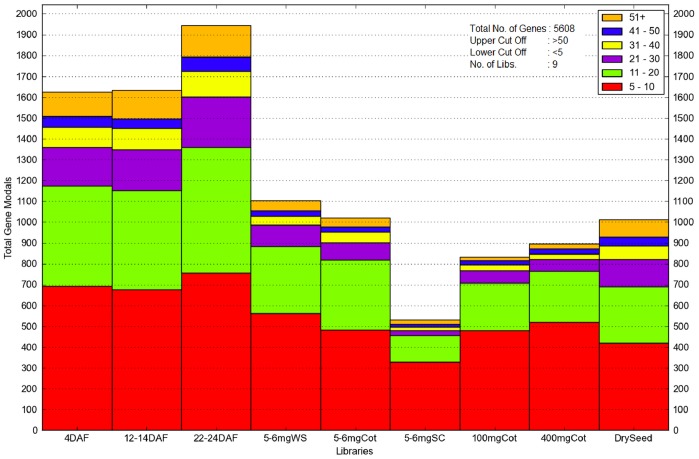
A histogram dividing 5608 transcription factor gene models into bins based on their RPKMs.Nine different libraries are shown, including 5–6 mg separated seed coat and cotyledon. Gene models must have RPKM≥5 at a stage to be displayed. Gene models with RPKM≥51 are compiled together at the top (orange). 5–6 mgWS = 5–6 mg whole seed.